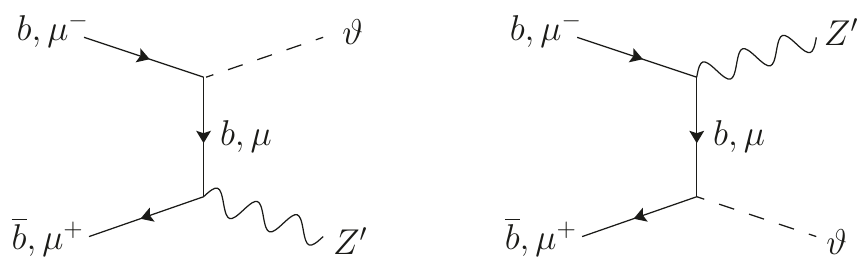
Figure 9. Flavon production with an associated Z 0 via a t -channel fermion exchange. The bot- tom quark exchange corresponds to hadron colliders, whereas muon exchange is possible at muon colliders. For the regions of parameter space considered in this work, the contribution to the ϑZ 0 production cross-section from this channel is typically of order 0 . 1% or